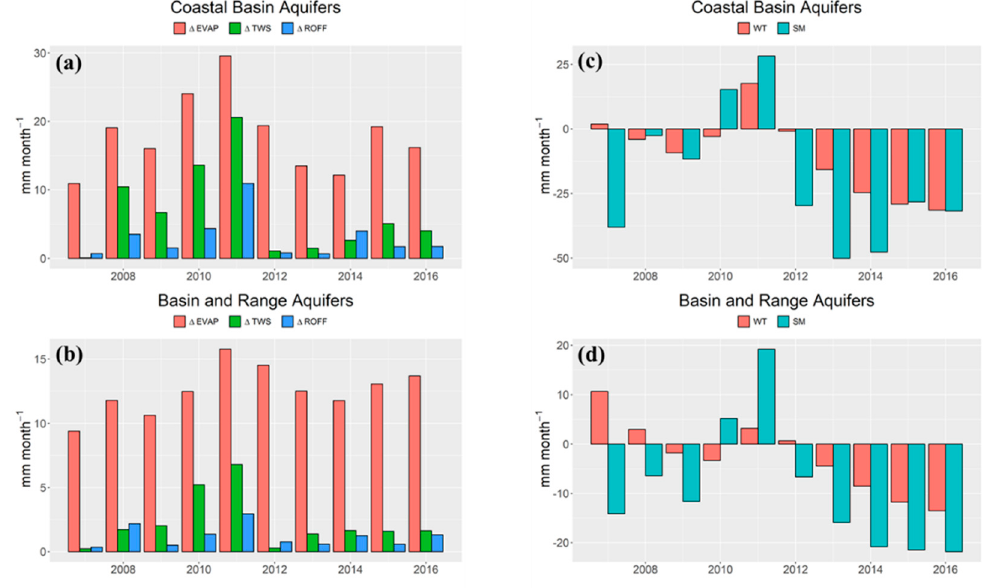
Figure 8. Water-year evapotranspiration, terrestrial water storage, and runoff rates for ( a ) Coastal Basin and ( b ) Basin and Range aquifer systems; and aquifer (WT) and soil moisture (SM) storages for ( c ) Coastal Basin and ( d ) Basin and Range aquifer systems. Unit: mm month − 1 .